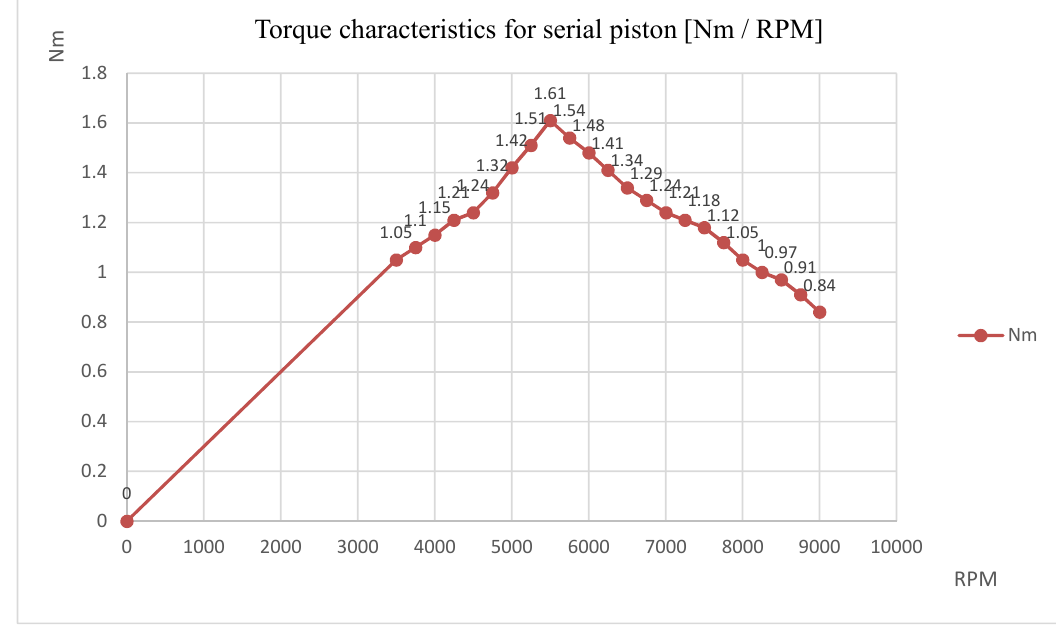
Figure 17. Engine torque characteristics for serial piston.